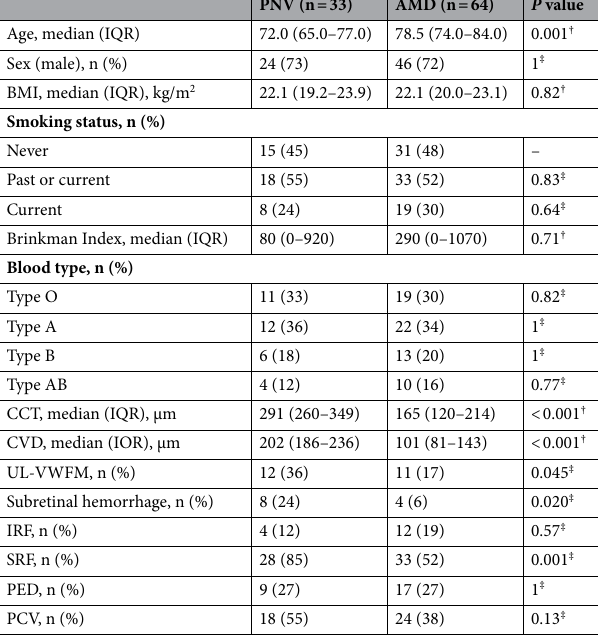
Table 2. The comparison of patients; PNV and AMD. PNV pachychoroid neovasculopathy, AMD age related macular degeneration, IQR inter-quartile range, CCT central choroidal thickness, CVD choroidal vessel